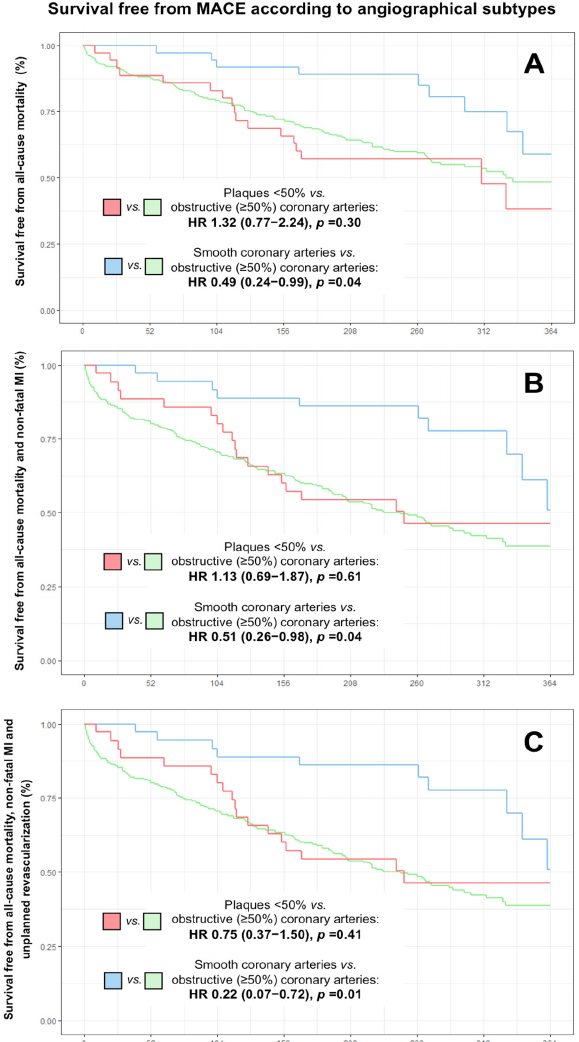
Figure 2. Survival free from all-cause mortality and MACE according to angiographic subtypes in elderly patients hospitalized for NSTEMI. ( A ) all-cause mortality; ( B ) all-cause mortality and non-fatal MI; ( C ) cardiovascular mortality, non-fatal MI and unplanned revascularization. Abbreviations: HR = hazard ratio; MACE = major adverse cardiac events; MI = myocardial infarction; NSTEMI = non-ST-segment elevation myocardial infarction.